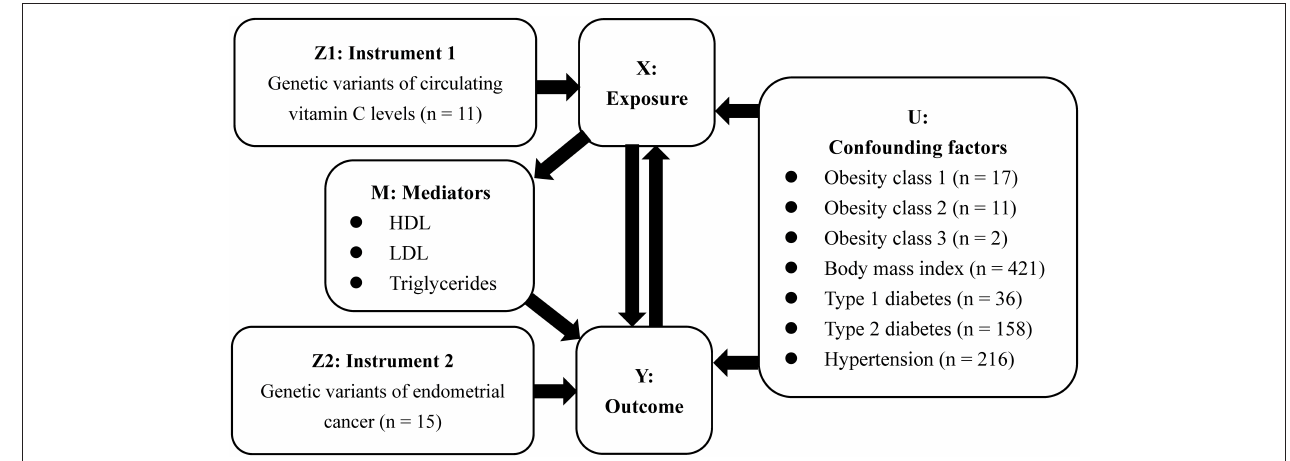
FIGURE 1 | Framework of bi-directional Mendelian randomization analysis in our